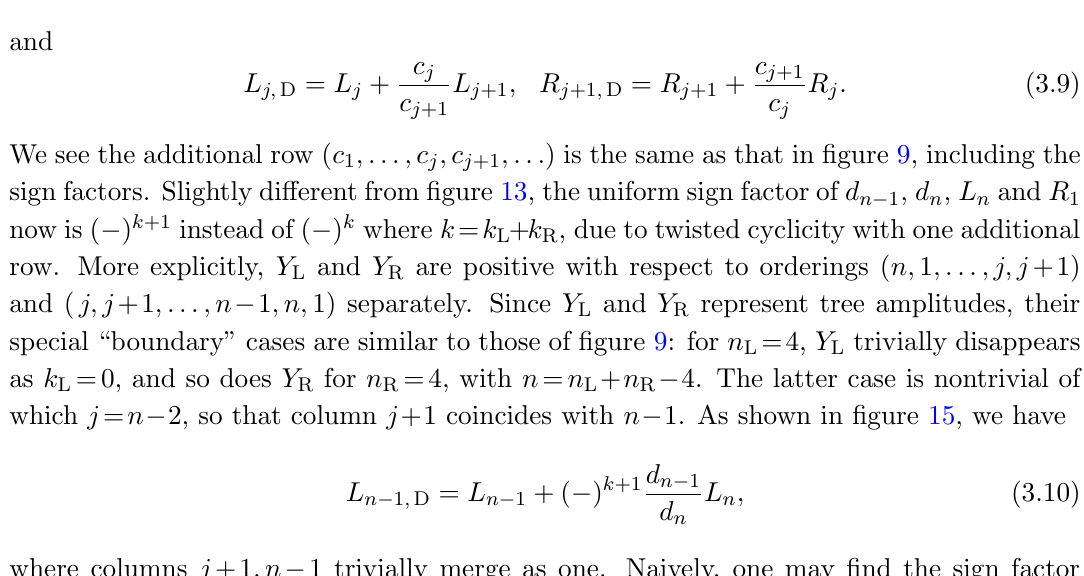
Figure 13 . Manifestly positive matrix structure containing three overlapped